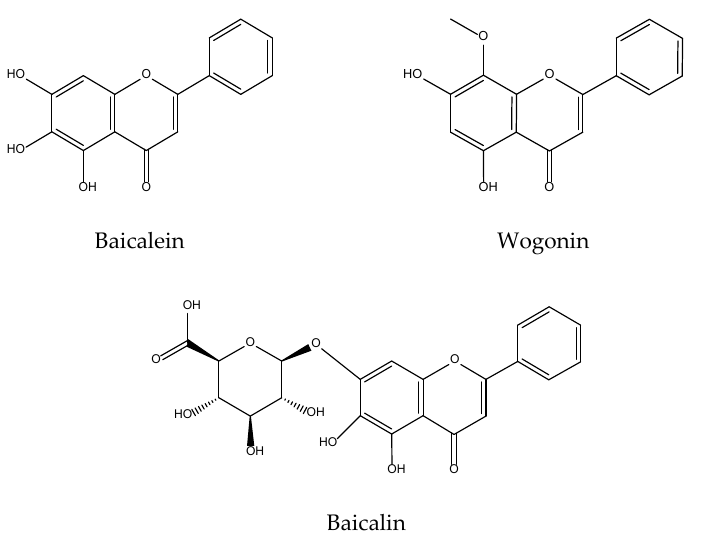
Figure 14. Bioactive anti-inflammatory (eicosanoid inhibition) and antioxidant principles from Scutellaria baicalensis .